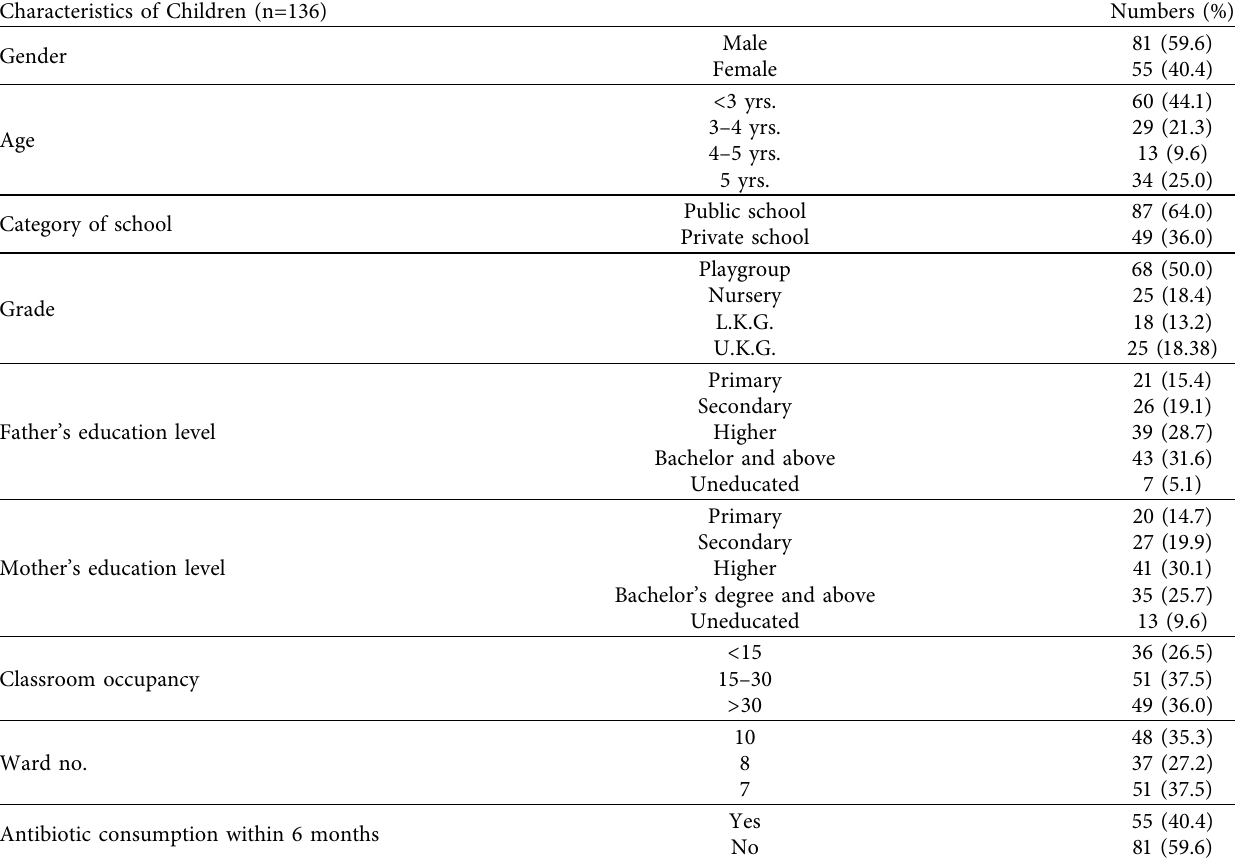
Table 2: Sociodemographic and clinical details of